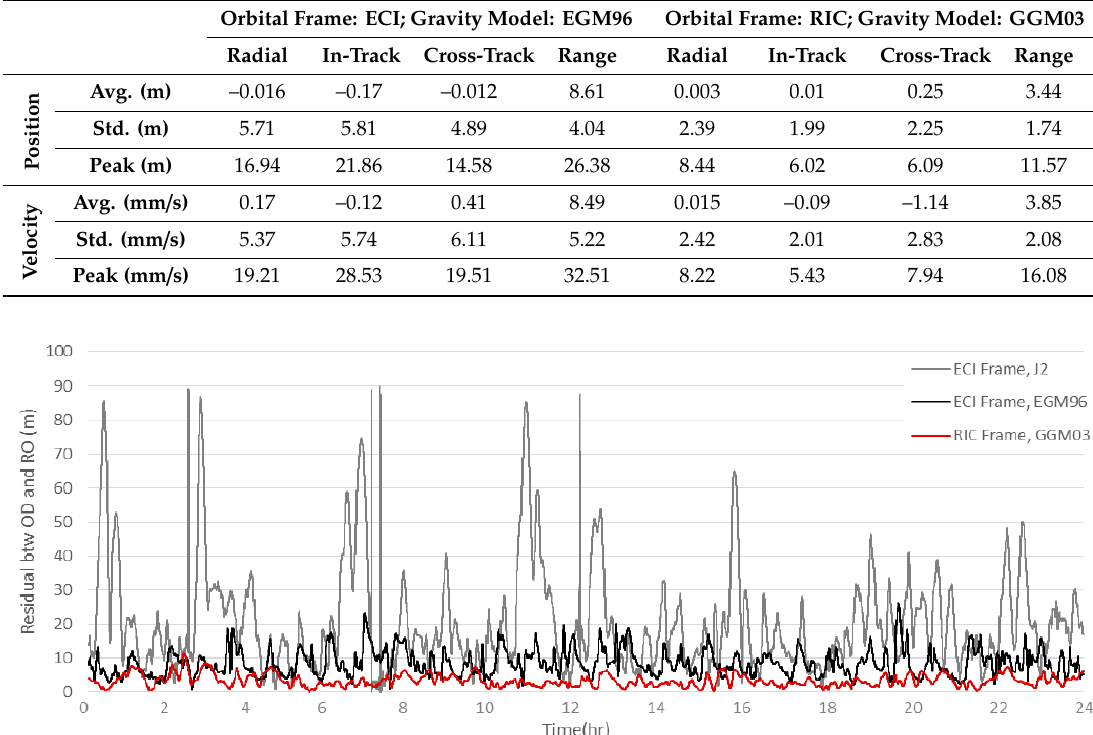
Table 6. Performance analysis results of on-board real-time orbit determination logic of the GPS-12 on DubaiSat-2 with respect to the reference orbit using Orbit Determination Tool Kit (ODTK).